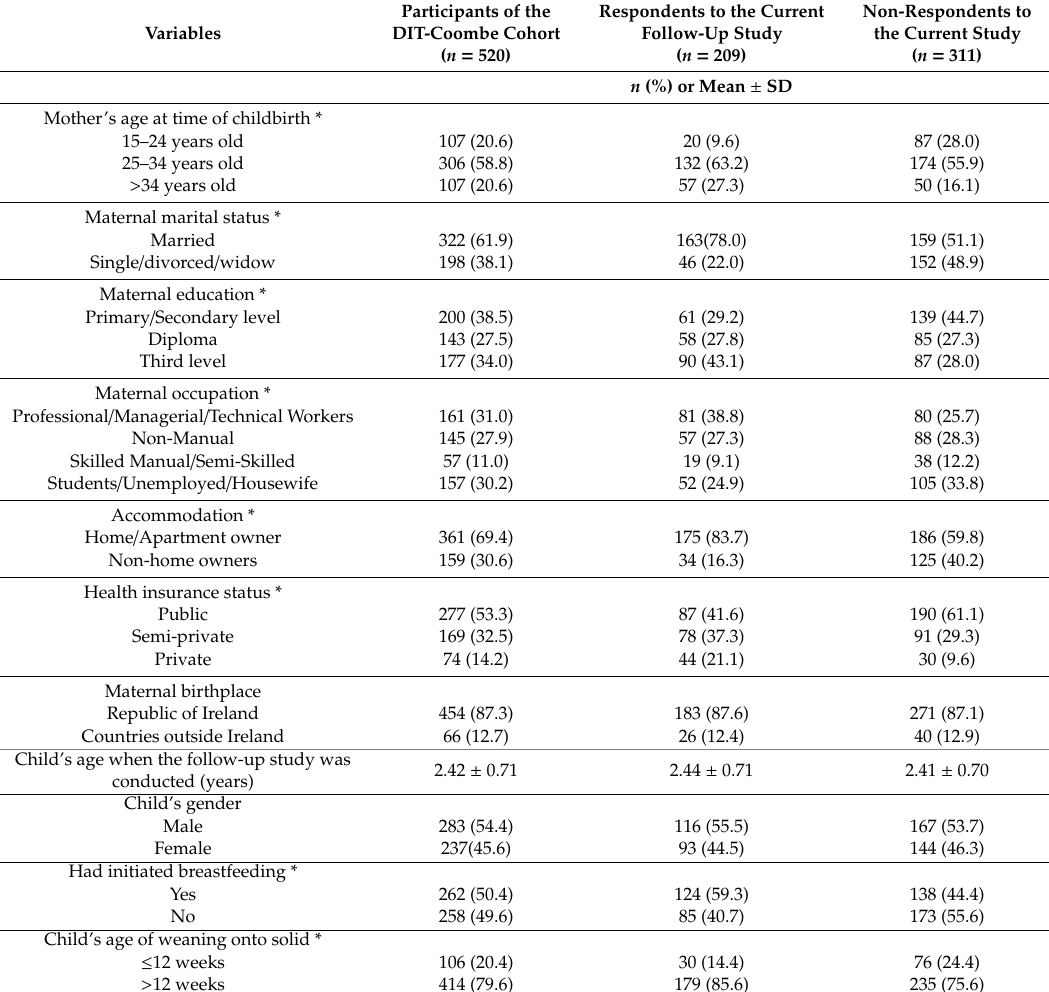
Table A2. Socio-demographic characteristics of participants of the Technological University Dublin (DIT)-Coombe Cohort study ( n = 520), respondents ( n = 209) and non-respondents ( n = 311) of the current follow-up